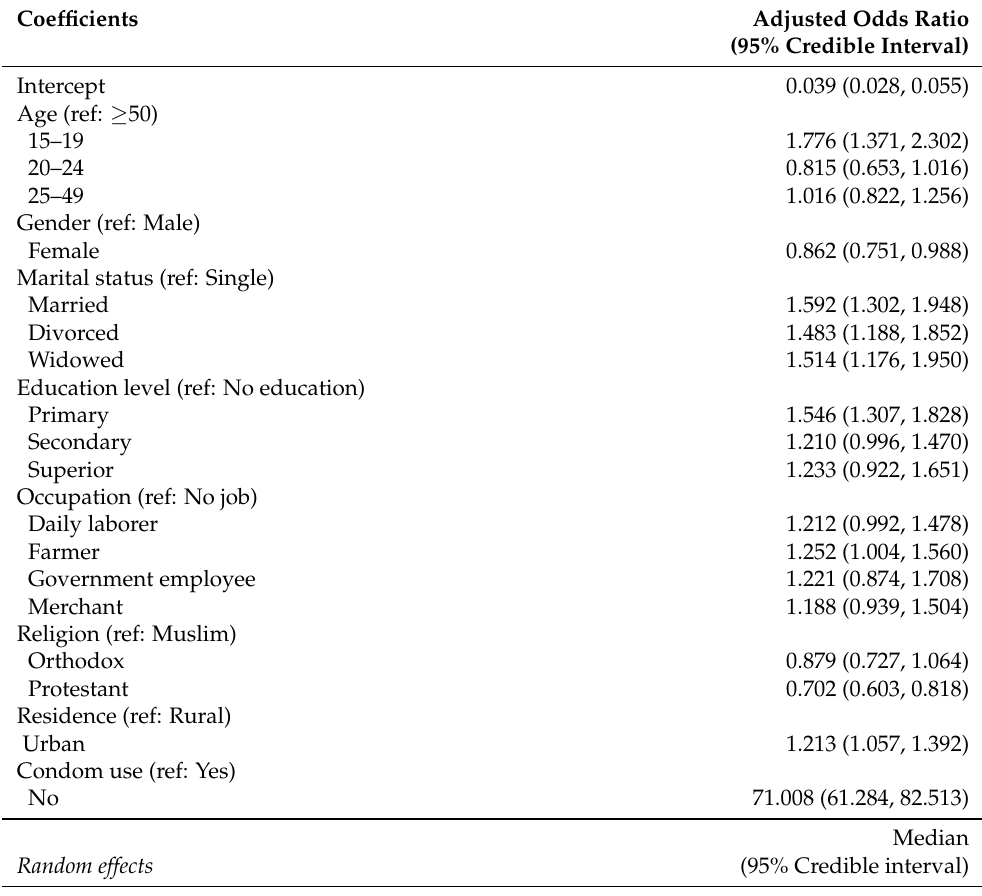
Table 2. Adjusted odds ratios (95% credible interval for parameters in the Bayesian spatial model fitted to the HIV data using ICAR